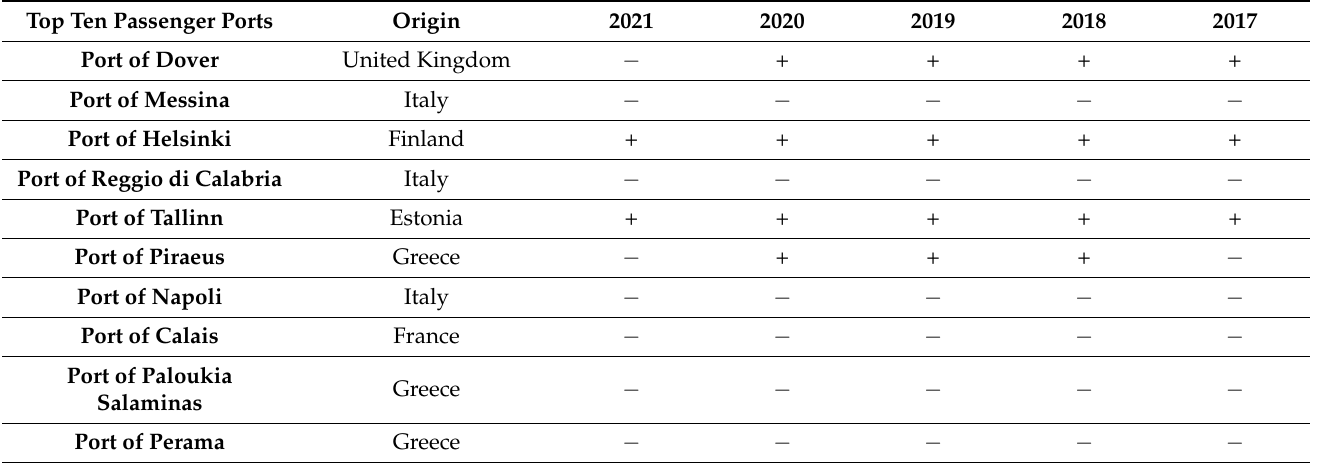
Table 3. Commitment to sustainability among the top 10 European passenger